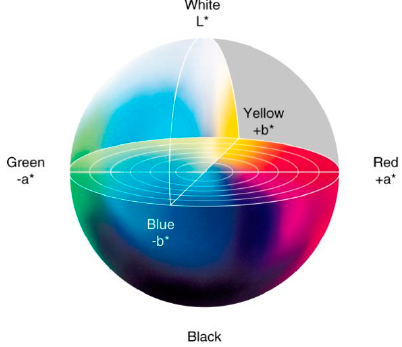
Figure 5. CIELAB color space.